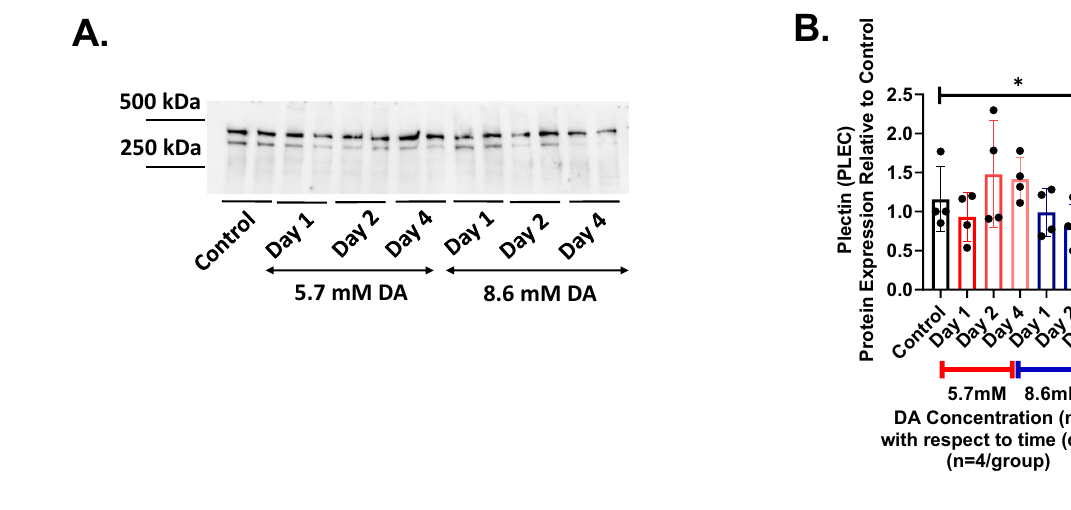
Figure 4. Changes in plectin abundance after DA exposure. ( A ) Representative western blot of plectin (PLEC) from epithelial cell culture homogenates at Days 1, 2 and 4 after DA exposure (5.7 and 8.6 mM). ( B ) Semi- quantification of PLEC abundance normalized to lane total protein that decreased significantly at Day 4 in cultures exposed to 8.6 mM DA compared to controls (ANOVA, *p < 0.05; n = 4/group).